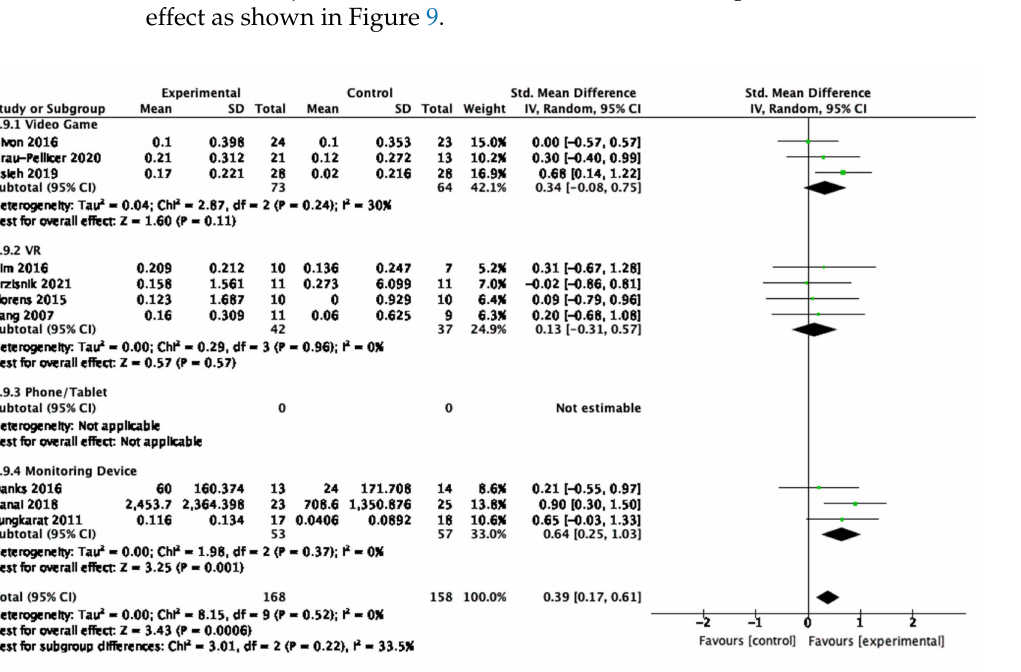
Figure 9. Subgroup analysis for the type of digital interventions that measured physical activity